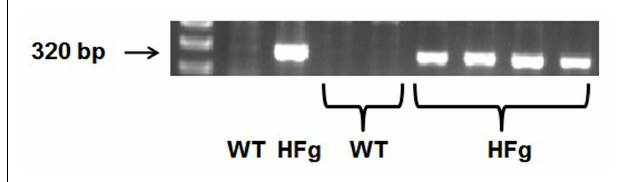
FIGURE 1 | Genotyping of hyperfibrinogenic (HFg) – fibrinogen transgene positive and wild type (WT) mice. Single PCR products suggest the homozygous mutation (HFg), while its absence representsWT